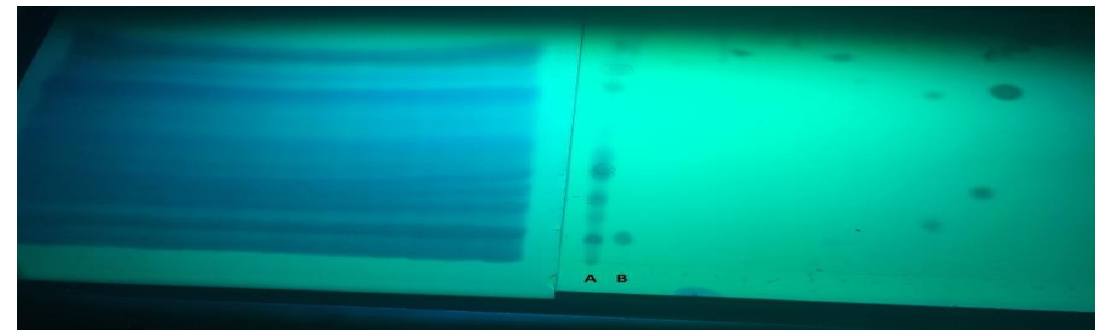
Fig. 9. preparative TLC for ethyl acetate fraction, A: ethyl acetate fraction, B: Rutin (standard), mobile phase: chloroform: methanol: formic acid (15: 4: